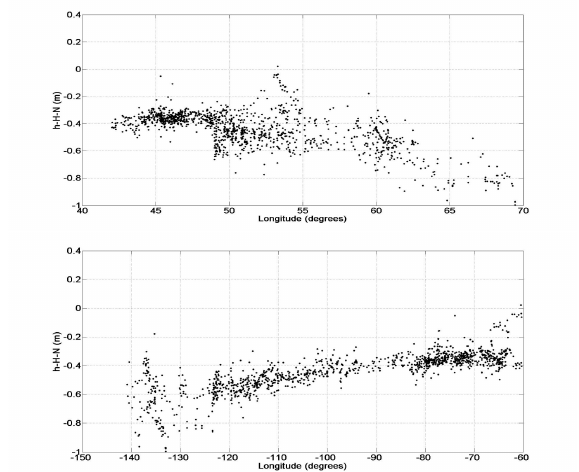
Figure 4. Systematic spatial tilts in S-N direction (top) and W-E di- rection (bottom) in the original geoid height differences h - H - N EGM 2008 , unit